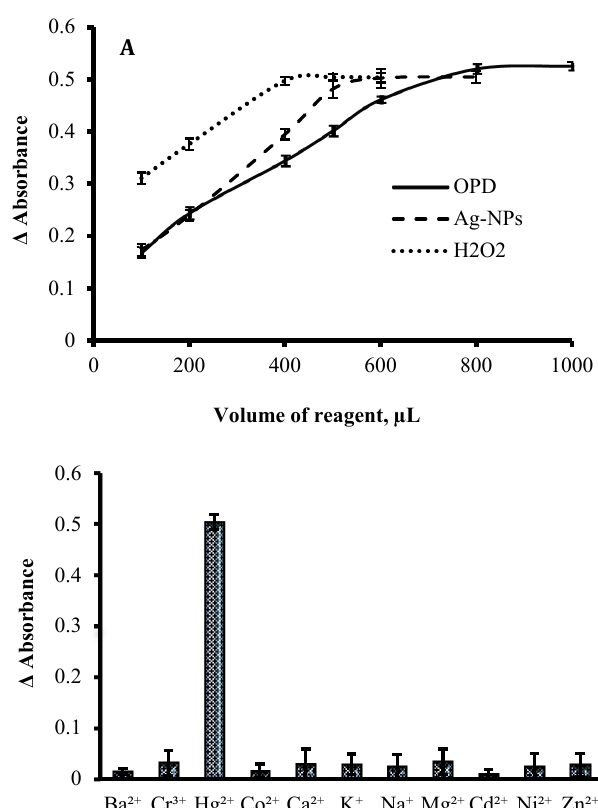
Figure 6. ( A , B ). Optimum volumes from reagent components for sensing Hg 2+ ions; ( B ) examining the colourimetric responses of PVP-AgNPs/OPD/H 2 O 2 system to various types of cations. The data are presented as mean ± SD (n = 3).